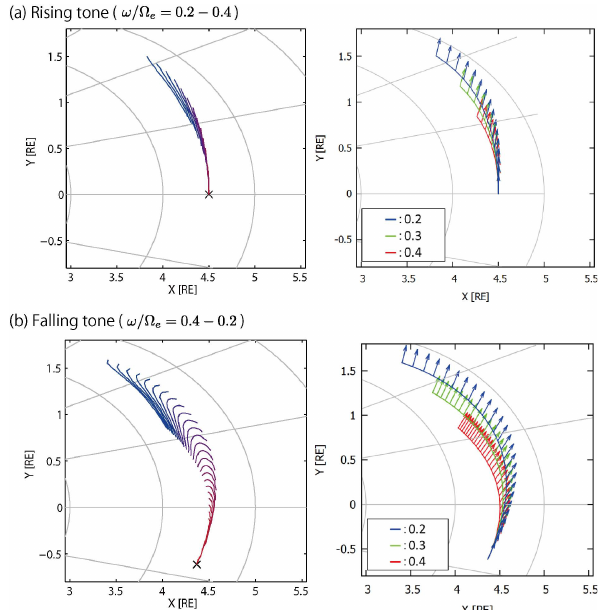
Fig. 6. Expanded equatorial view for L = 4 . 5 for lower-band rising and falling tone, f = 0 . 2–0.4 (cid:127) e / 2 π (Hz) and f = 0 . 4–0.2 (cid:127) e / 2 π (Hz), respectively, as in Fig. 5, but with all rays starting at the local Gendrin